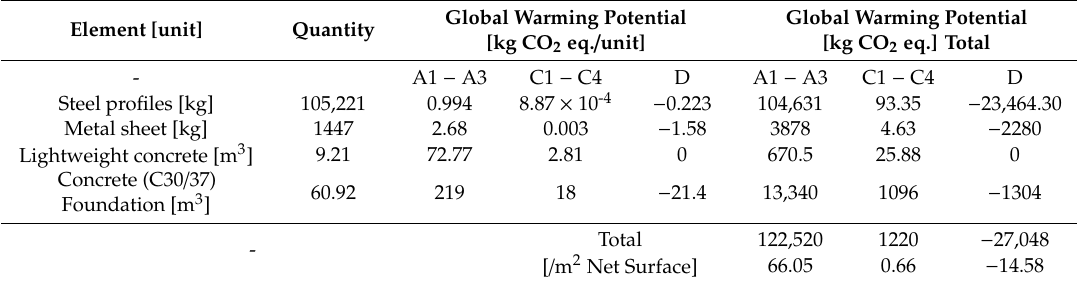
Figure 2. A schematic representation of ( a ) Reference building and ( b) Diagrid retrofit system. Table 3. Diagrid data collection and LCIA results (Source: Generis [38]).